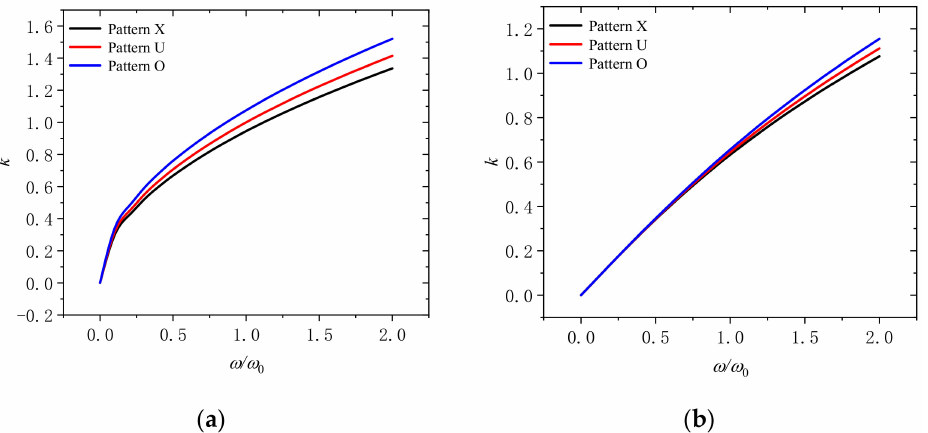
Figure 9. Wavenumber dispersion in a rotating microbeam with different distribution patterns of GPLs (pattern X, pattern U, and pattern O) for ( a ) Ω / Ω 0 = 0 and ( b ) Ω / Ω 0 =